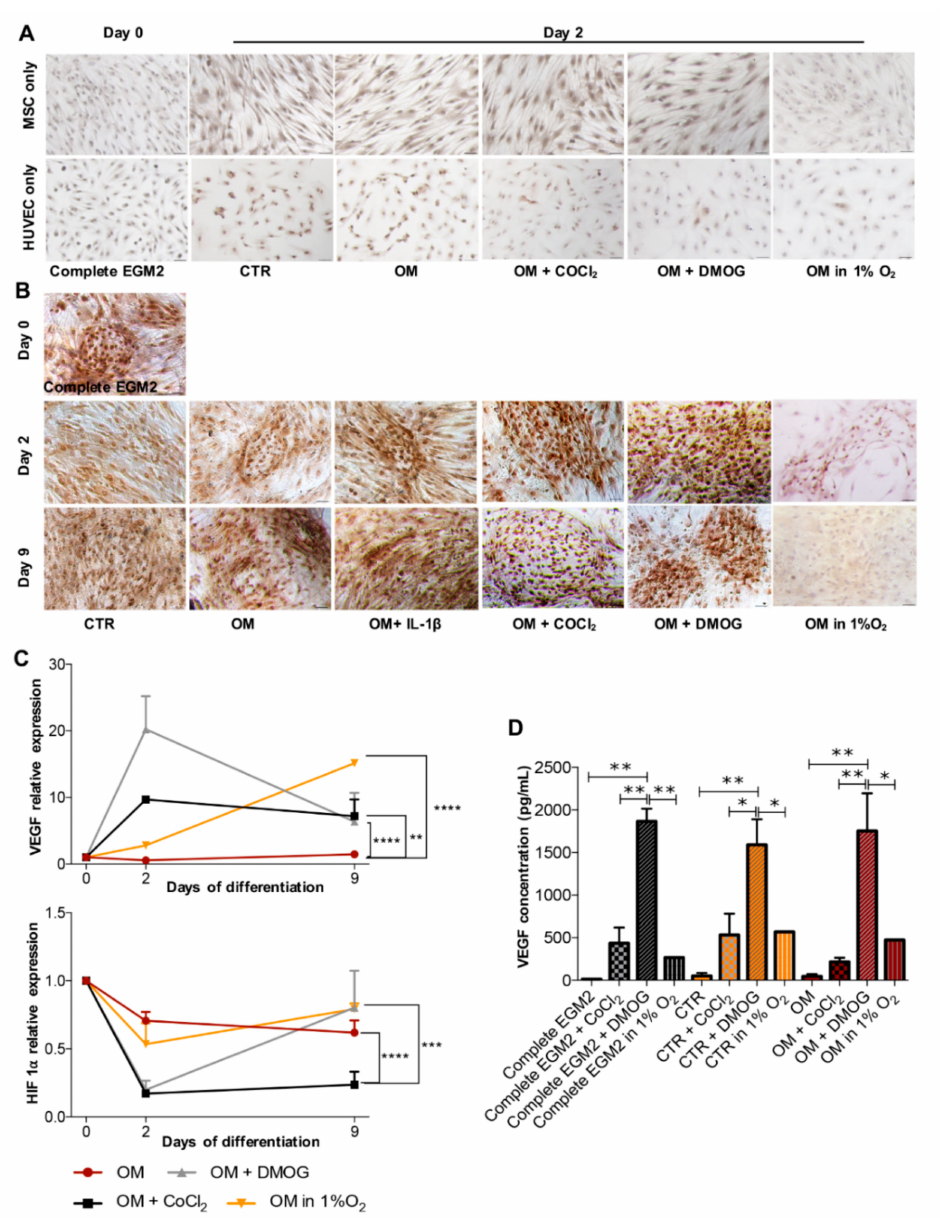
Figure 4. In vitro angiogenesis. ( A ) IHC analysis of vascular endothelial growth factor (VEGF) (brown) expressed by BMSC and HUVEC in monoculture at day 0 in medium Complete EGM2 and at day 2 in media CTR, OM, OM supplemented with COCl 2 or DMOG and OM in 1% O 2 , scale bar 50 µ m. ( B ) IHC result of VEGF expression by the cocultured cells, scale bar 50 µ m. ( C ) qPCR presents relative gene expression of VEGF and HIF 1 α of the cells cocultured in media OM, OM supplemented with COCl 2 or DMOG and OM in 1% O 2 over time (n = 3, ∗∗ p ≤ 0.0029, ∗∗∗ p = 0.0004, ∗∗∗∗ p < 0.0001). ( D ) ELISA data shows the concentration of VEGF released in the supernatant by the cocultured cells in three groups: Complete EGM2, CTR, and OM. In each group, the cells were incubated with or without COCl 2 or DMOG and in 1% O 2 for 24 h then in the medium supplemented with 0.1% FBS only for another 24 h (n = 3, ∗ p < 0.05, ∗∗ p <